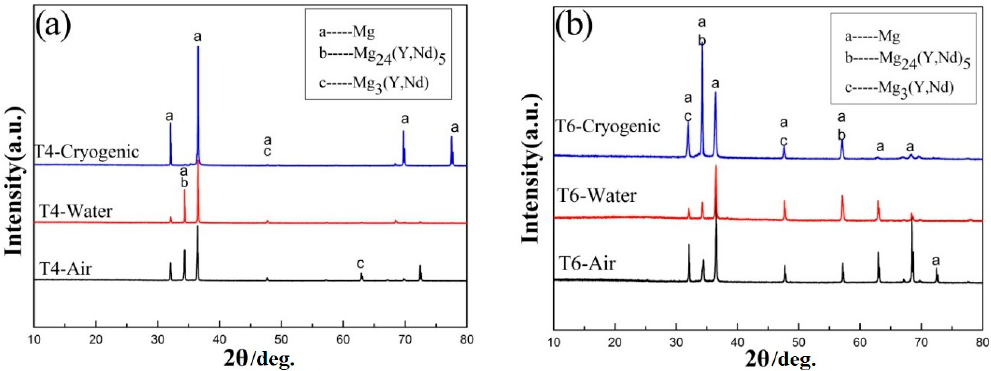
Figure 8. X-ray diffractions of different samples: ( a ) T4; ( b ) T6.